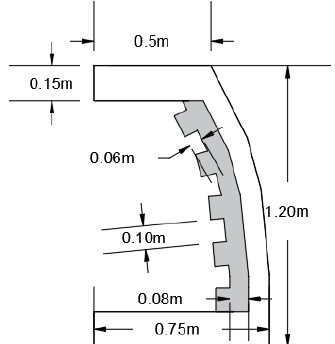
Figure 17. Illustration of barrier geometry and porous material.